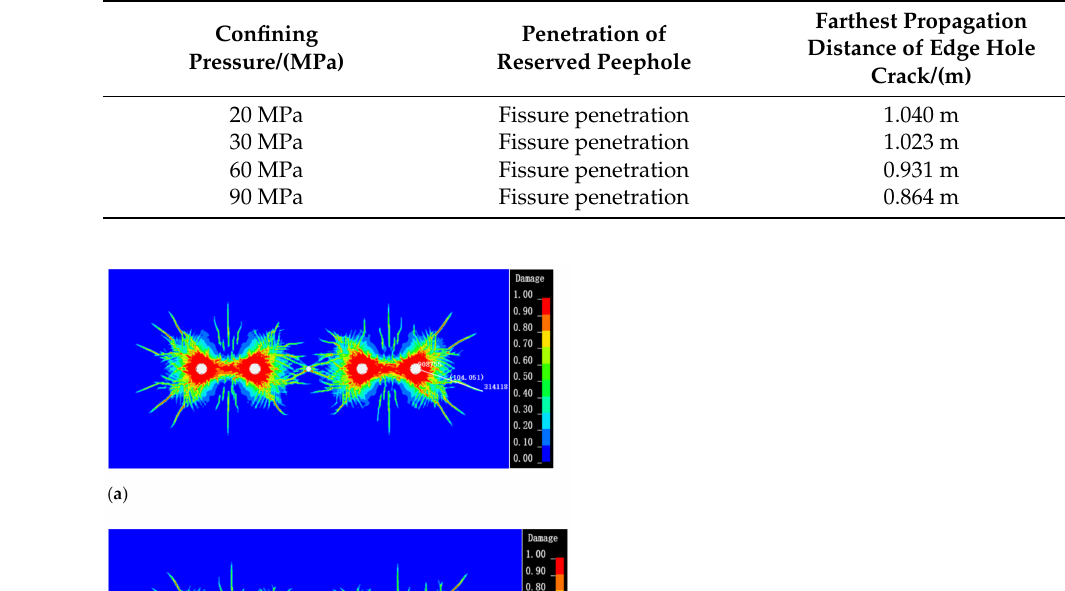
Table 6. Penetration propagation of blasting cracks under different confining pressures.